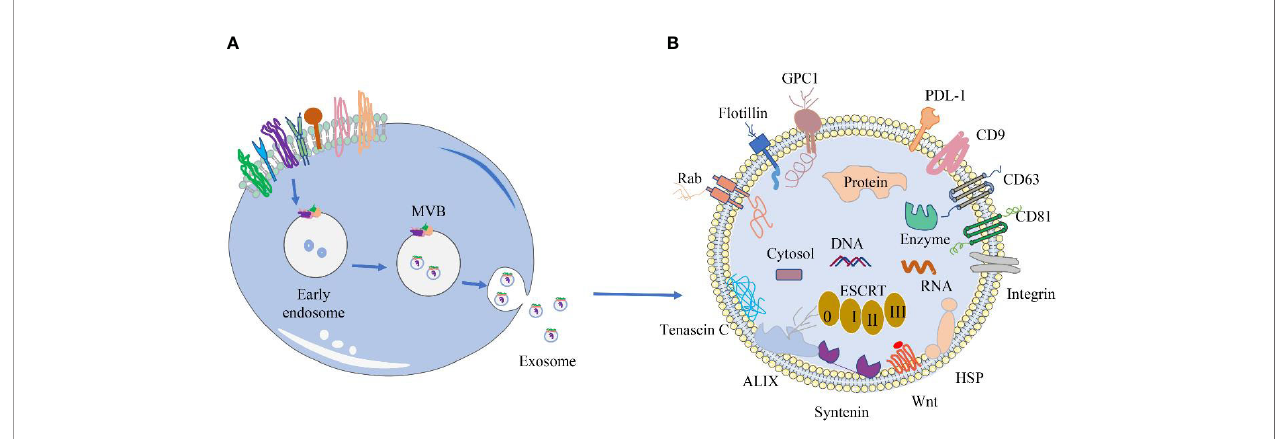
FIGURE 1 | Origin of sEVs and distribution of different sEV membrane proteins. (A) Origin of sEVs. sEVs are produced through the exosomal pathway. First, plasma membrane invagination of donor cells forms early endosomes, which further mature into late endosomes. During the maturation, the membrane of early endosomes invaginates inwardly to form ILVs. Endosomes with ILVs are often referred to as MVBs. When MVBs fuse with the plasma membrane, ILVs are released into the extracellular space and termed as sEVs. (B) Common membrane proteins of sEVs. Tetraspanin proteins (CD9, CD63, CD81), PD-L1, Integrins; Wnt protein, ALIX,